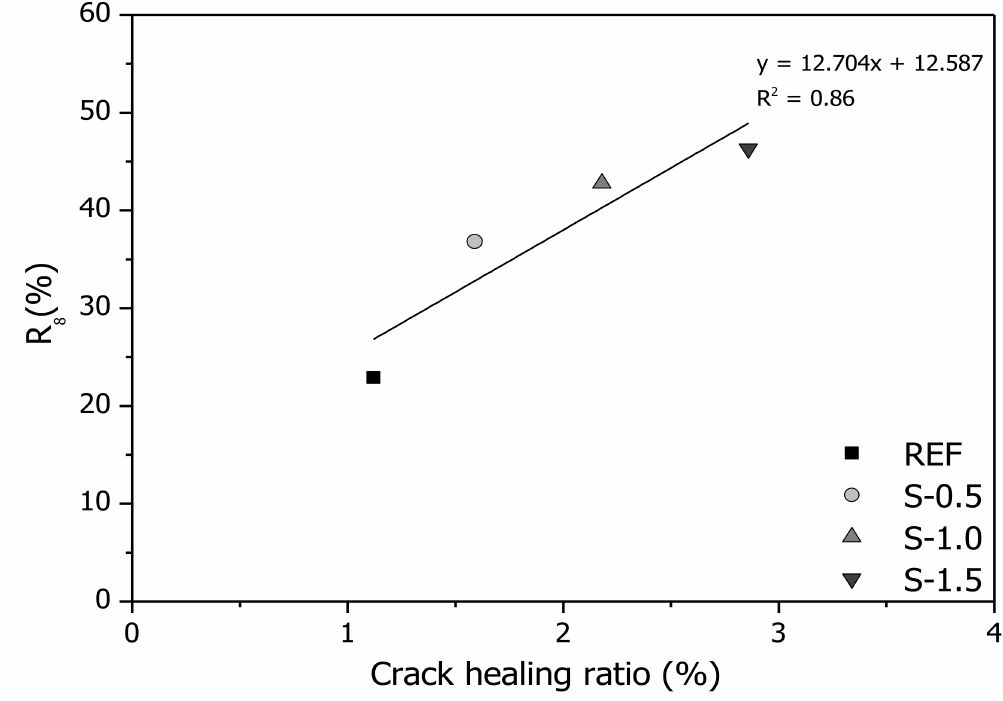
Figure 15. Relationship between reduction ratio of initial sorptivity at eighth cycle ( R 8 ) and crack healing